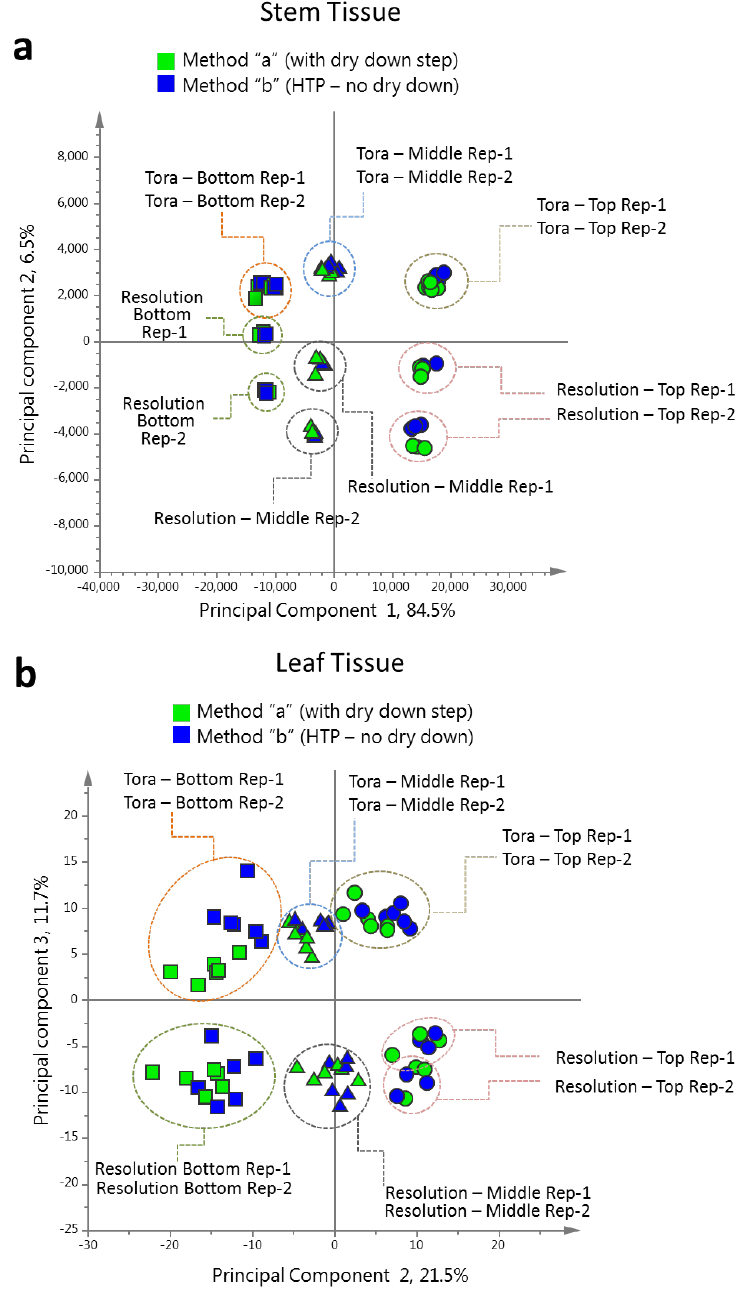
Figure 10. Comparison of binned 1D 1 H-NMR data from extracts prepared by method “a” and method “b” (Figure S7). ( a ) PCA scores plot of willow stem 1D 1 H-NMR data coloured by method used to prepare NMR extracts; green: method “a”; blue: method “b”. ( b ) PCA scores plot of willow leaf 1D 1 H-NMR data coloured by method used to prepare NMR extracts; green: method “a”; blue: method